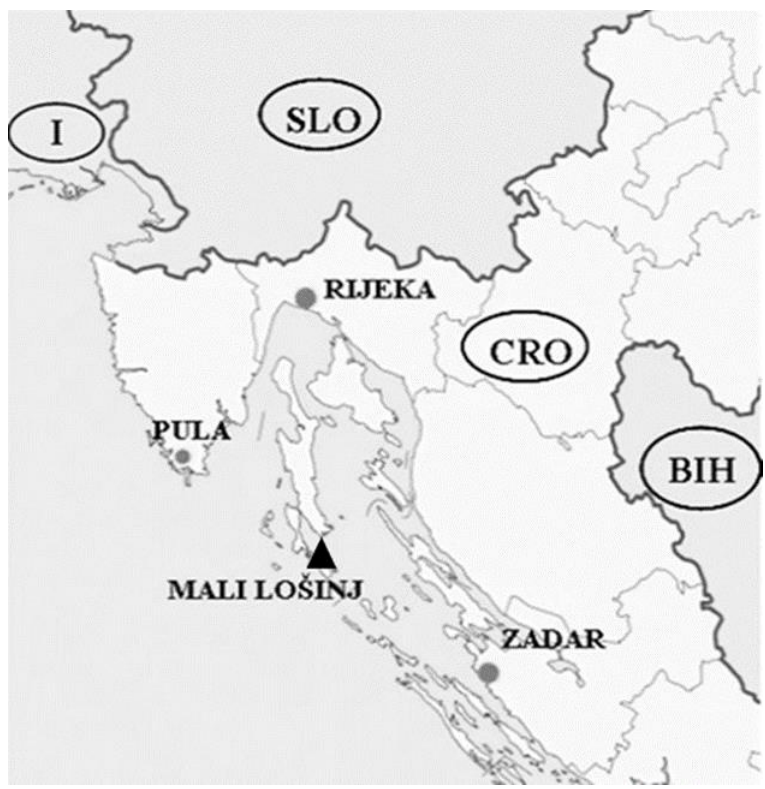
Figure 1. Location of the monitoring station Mali Lošinj, Croatia (marked with a triangle) with the surrounding area.